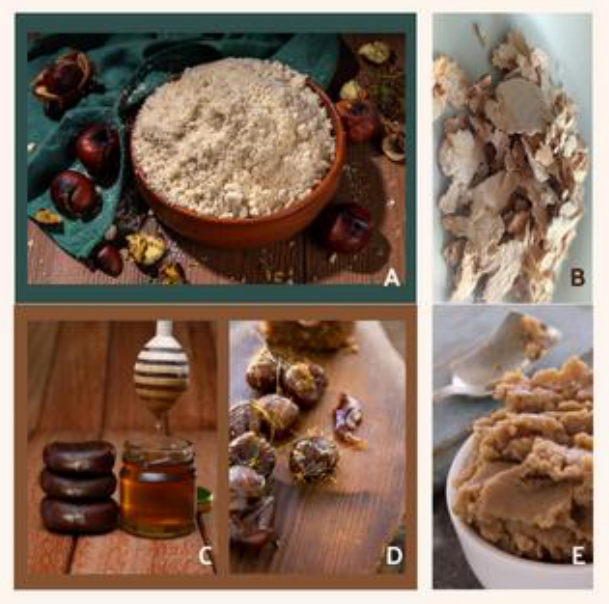
Figure 4. Examples of products made from chestnuts and the chestnut tree. ( A ) — chestnut flour; ( B ) — chestnut flakes; ( C ) — chestnut honey; ( D ) — candied chestnut; ( E ) — chestnut purée. Roasting of the chestnuts is well accepted by tasters because of their sweetness, com- ing from the sucrose content. The chestnuts for roasting should be selected according to